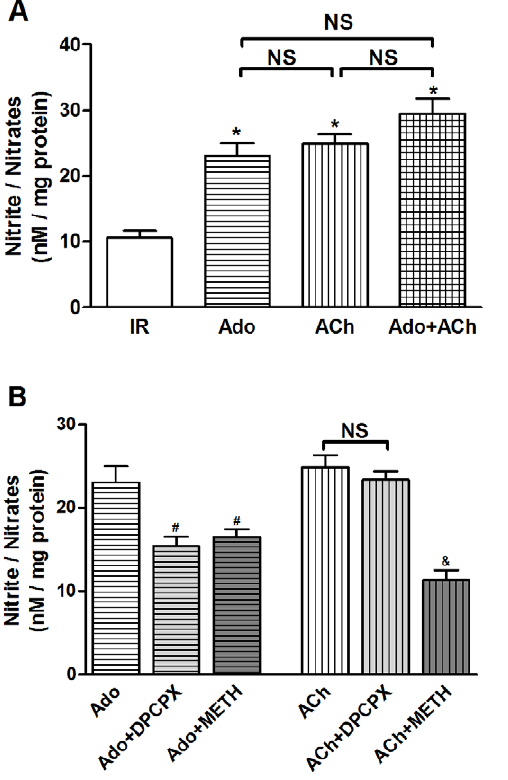
Figure 2. Effects of adenosine/acetylcholine and receptors blockade on NO x production. (A) Adenosine/acetylcholine in- creased the production of NO x in ischemic-reperfused rat hearts; (B) A 1 AR antagonist DPCPX abolished the increase of NO x afforded by adenosine. M 2 AChR antagonist METH blunted the increase of NO x mediated by adenosine and abolished this effect of acetylcholine. * P , 0.01 vs. IR; # P , 0.01 vs. Ado; & P , 0.01 vs. ACh; NS: not significance (n=6 in each group).